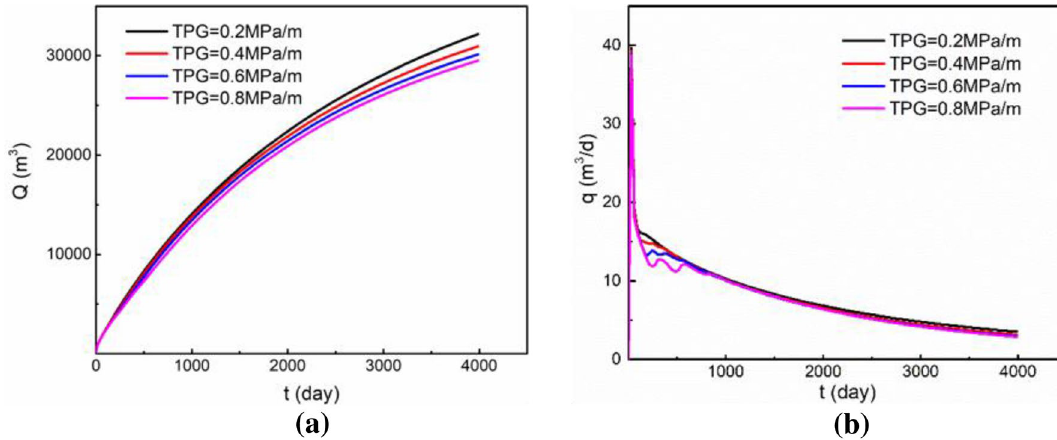
Fig. 3 a Cumulative oil production curve; b daily oil production